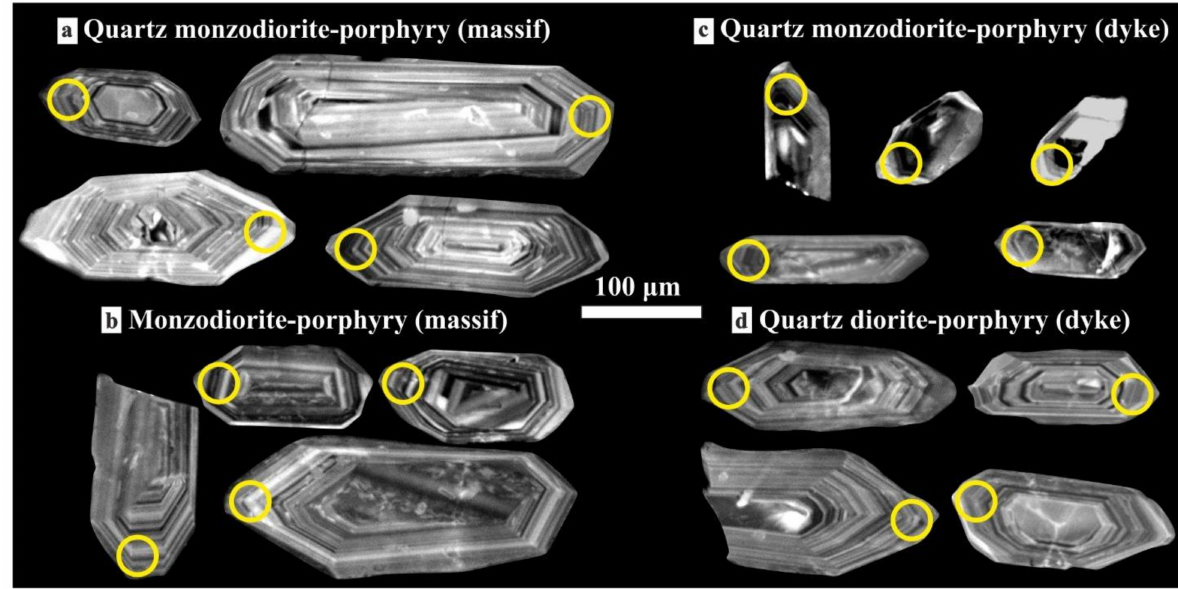
Figure 6. Cathodoluminescence (CL) images of representative zircon grains with laser spots from the magmatic ( a , b ) massif and ( c , d ) dyke rocks of the Kultuma